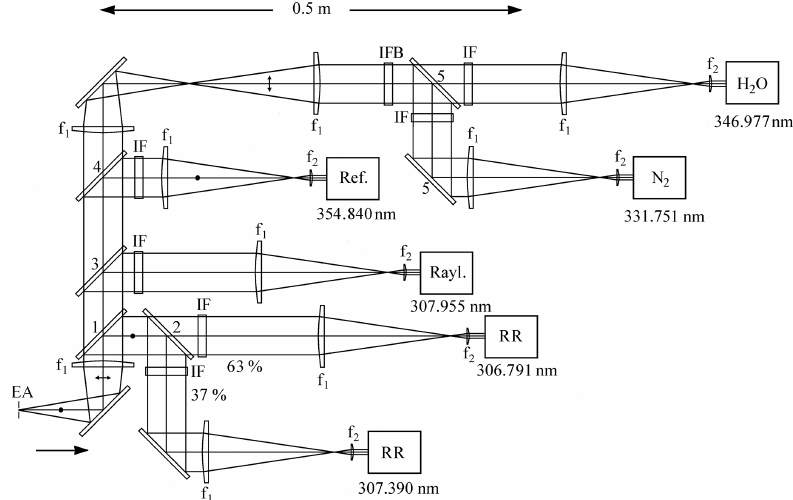
Figure 8. Final polychromator design. The true orientation of the mounting plate (vertical) is rotated clockwise by 90 ◦ . The radiation cone from the telescopes (arrow) enters the polychromators from behind the plate as indicated by the polarization dot next to the arrow. In detail, EA: entrance aperture with four adjustable blades (OWIS); 1: beam splitter, transmitting almost all P-polarized radiation (308– 355nm) and highly reflecting the S-polarized 308nm radiation; 2: 63% / 37% beam splitter for S-polarized 308nm radiation; 3: beam splitter reflecting all radiation at 308nm and transmitting 83%–91% of the longer wavelength P components; 4: polarizing beam splitter; 5: sharp- edged long-pass filter for P polarization, reflecting about 99% at 332nm and transmitting 99% of the longer wavelength components ; IF: narrowband interference filters; IBF: broadband interference filter transmitting between 330 and 355nm with T = 85%–90% and blocking the radiation outside this range by at least 10 5 ; lenses: f 1 = 150mm and f 2 = 18mm (large telescope), f 2 = 30mm (small telescope). Detailed specifications are given in Table 3.